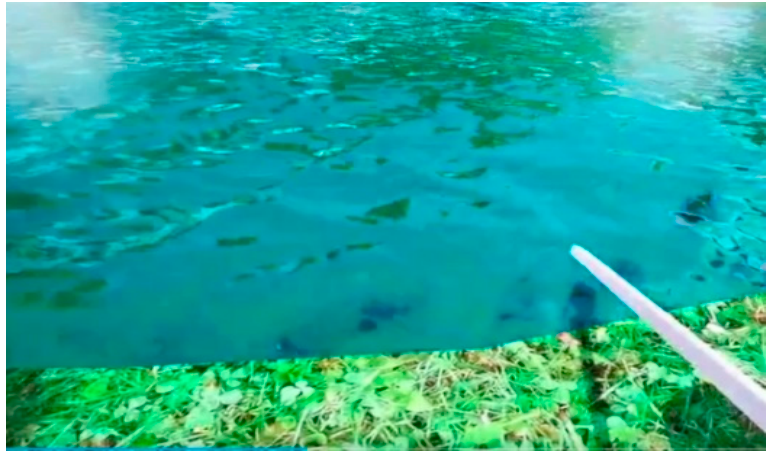
Figure 9. Screenshot of the interactive activity in a restorative garden: fishing.